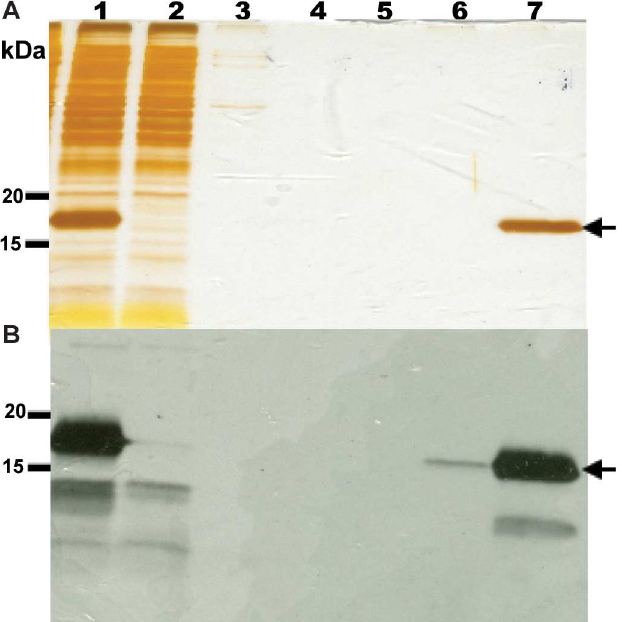
Fig 6. Protein analysis of the talon metal affinity chromatography purification of PelB-Vpu. Protein fractions were subjectedto SDS-PAGE followedby silver staining( A ) and immunoblotting ( B ). Detergent ( β DDM)-solublefraction containing PelB-Vpu(lane 1) was loadedonto a column containing Talon resin that was pre-equilibrated with 20 mM HEPES, pH 7.5, supplemented with 500 mM NaCl, 5 mM imidazole, and 0.02% β DDM. Unboundproteinsin the flow through were collected(lane 2) and the column was washed consecutively with four different buffer solutions(20 mM HEPES, pH 7.5): W1 (lane 3, buffer plus 500 mM NaCl), W2 (lane 4, buffer plus 500 mM NaCl and 0.02% β DDM), W3 (lane 5, buffer plus 250 mM NaCl and 0.02% β DDM), and W4 (lane 6, buffer plus 250 mM NaCl, 0.02% β DDM and 10 mM imidazole). Pure PelB-Vpuwas eluted with W4 buffer supplemented with 300 mM imidazole(lane 7,